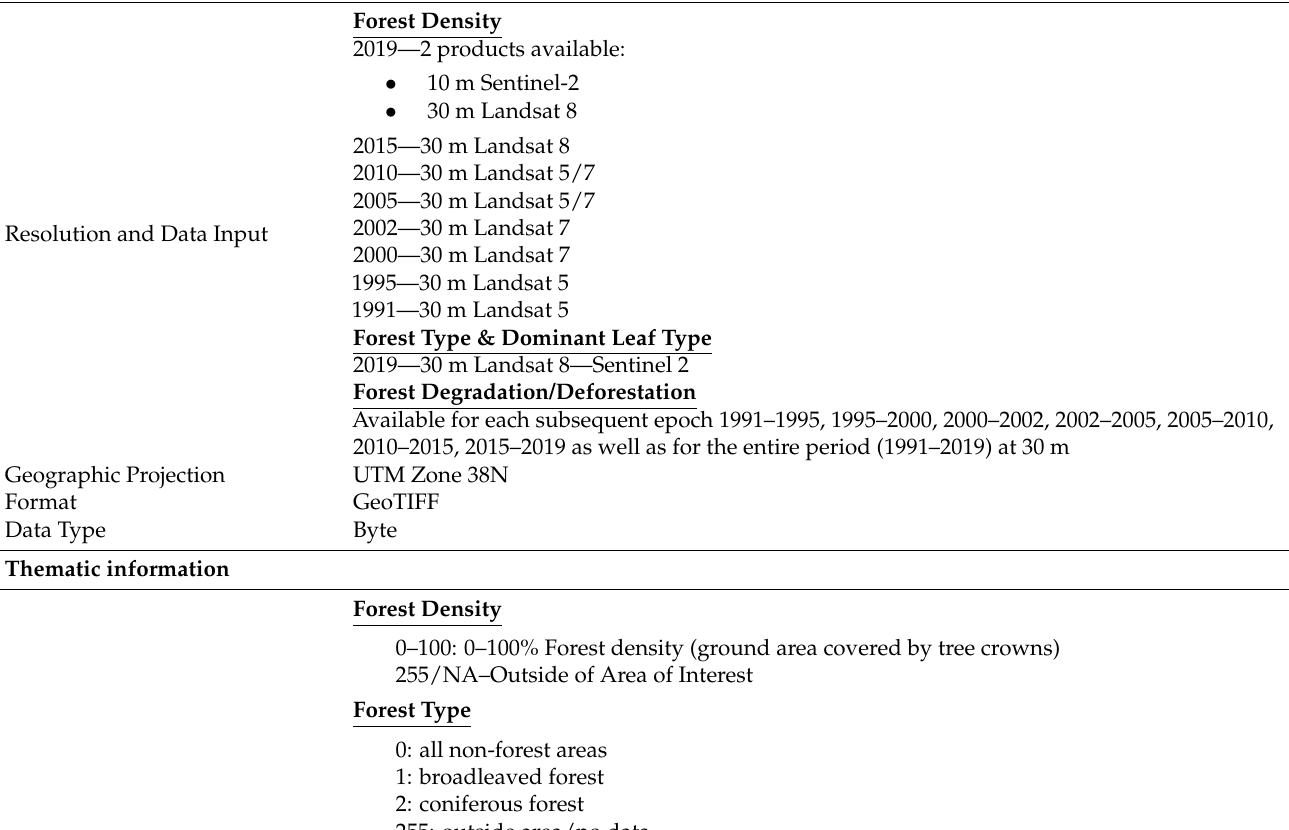
Table 1. Product specifications for Service 2 Forest